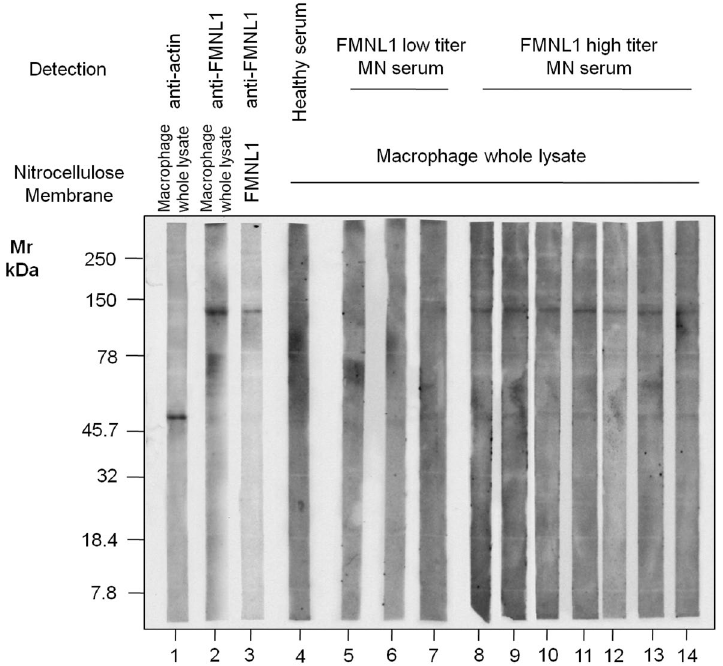
Figure 5. Characterization of macrophage antigens profile recognized by serum of healthy donors and MN patients. Representative western blot analysis of full length gel of macrophage antigen profile. Recombinant FMNL1 (lane 3) and macrophage whole lysate (lanes 1–2, and 4–12) were separated by SDS-PAGE in reducing conditions, transferred onto nitrocellulose membrane, and incubated with monoclonal anti-actin (lane 1), monoclonal anti-FMNL1 (lanes 2 and 3), a pool of healthy serum (lane 4) or MN patients low titer (lanes 5–7) or high titer (lanes 8–14) for anti-FMNL1 ELISA assay. Finally, membranes were developed, at the same time, with anti-Mouse IgG-HRP conjugated (lane 1–3) or anti-Human IgG4 HRP conjugated (4–14). IgG4 of MN patients with high titer for anti-FMNL1 in ELISA recognizes a band with the same molecular weight